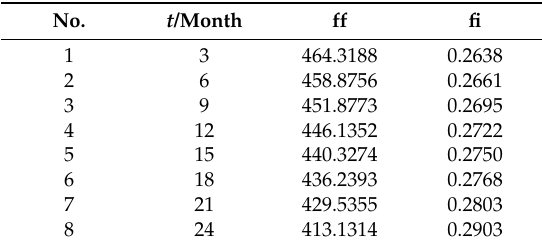
Table 2. Characteristic parameters of limit strength.